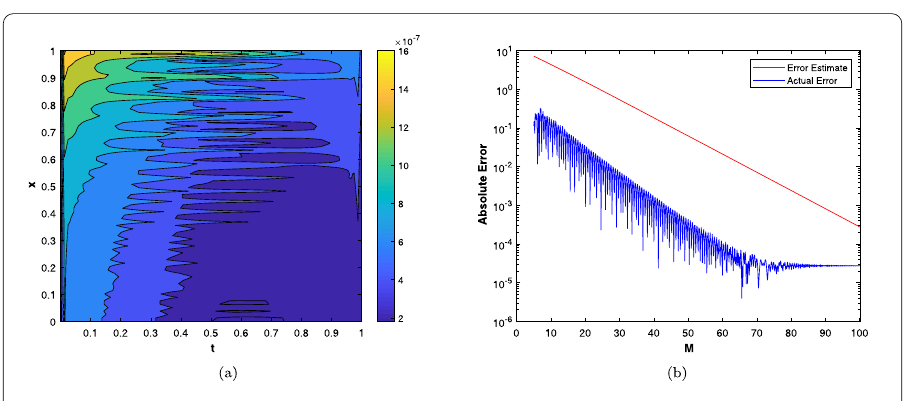
Figure 9 ( a ) The contour plot of absolute error. ( b ) The actual error vs error estimate